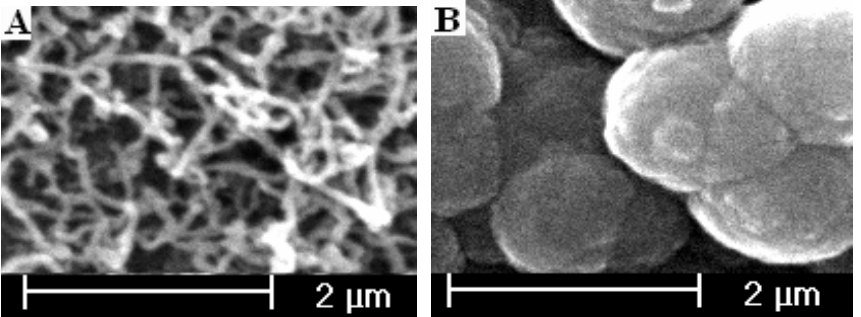
Figure. 1 SEM pictures of polypyrrole modified electrode surface. (A: Nanowires; B: cauliflower).